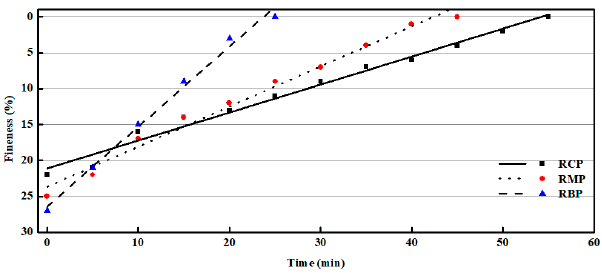
Figure 4. The influence of grinding time on the RP fineness.